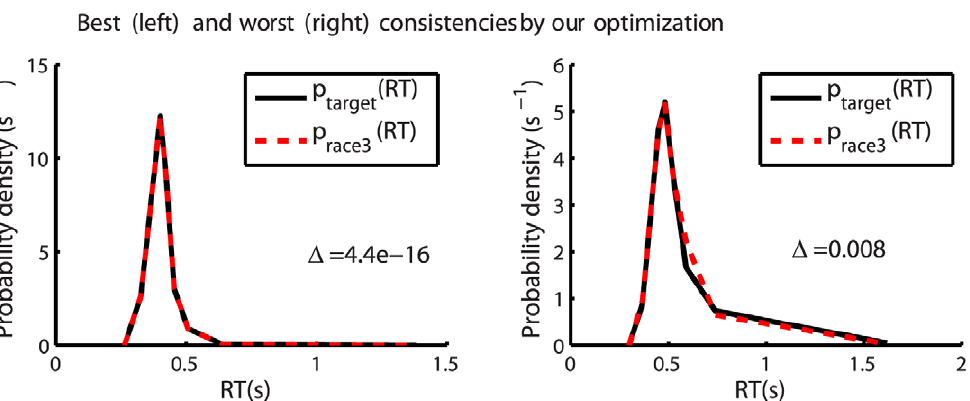
Figure 5. Visualization of the consistency of our method. Shown are the best and the worst consistencies in using our optimization method to probe the double feature tuned cells, among all subjects and all double feature target conditions. A better consistency means a better match between the two curves p target ( RT target ) and p race3 ( RT race3 ) . Here, p target ( RT target ) is the distribution of the behavioral RT data for a double feature target. Meanwhile, p race3 ( RT race3 ) is the corresponding distribution of the winning RT from a race between the three RT racers (e.g., see Fig. 4) whose probability distributions are inferred from the behavioral RT data by our optimization method. In most cases (not shown here), the two curves are not visually distinguishable, similar to that in the plot for the best case.